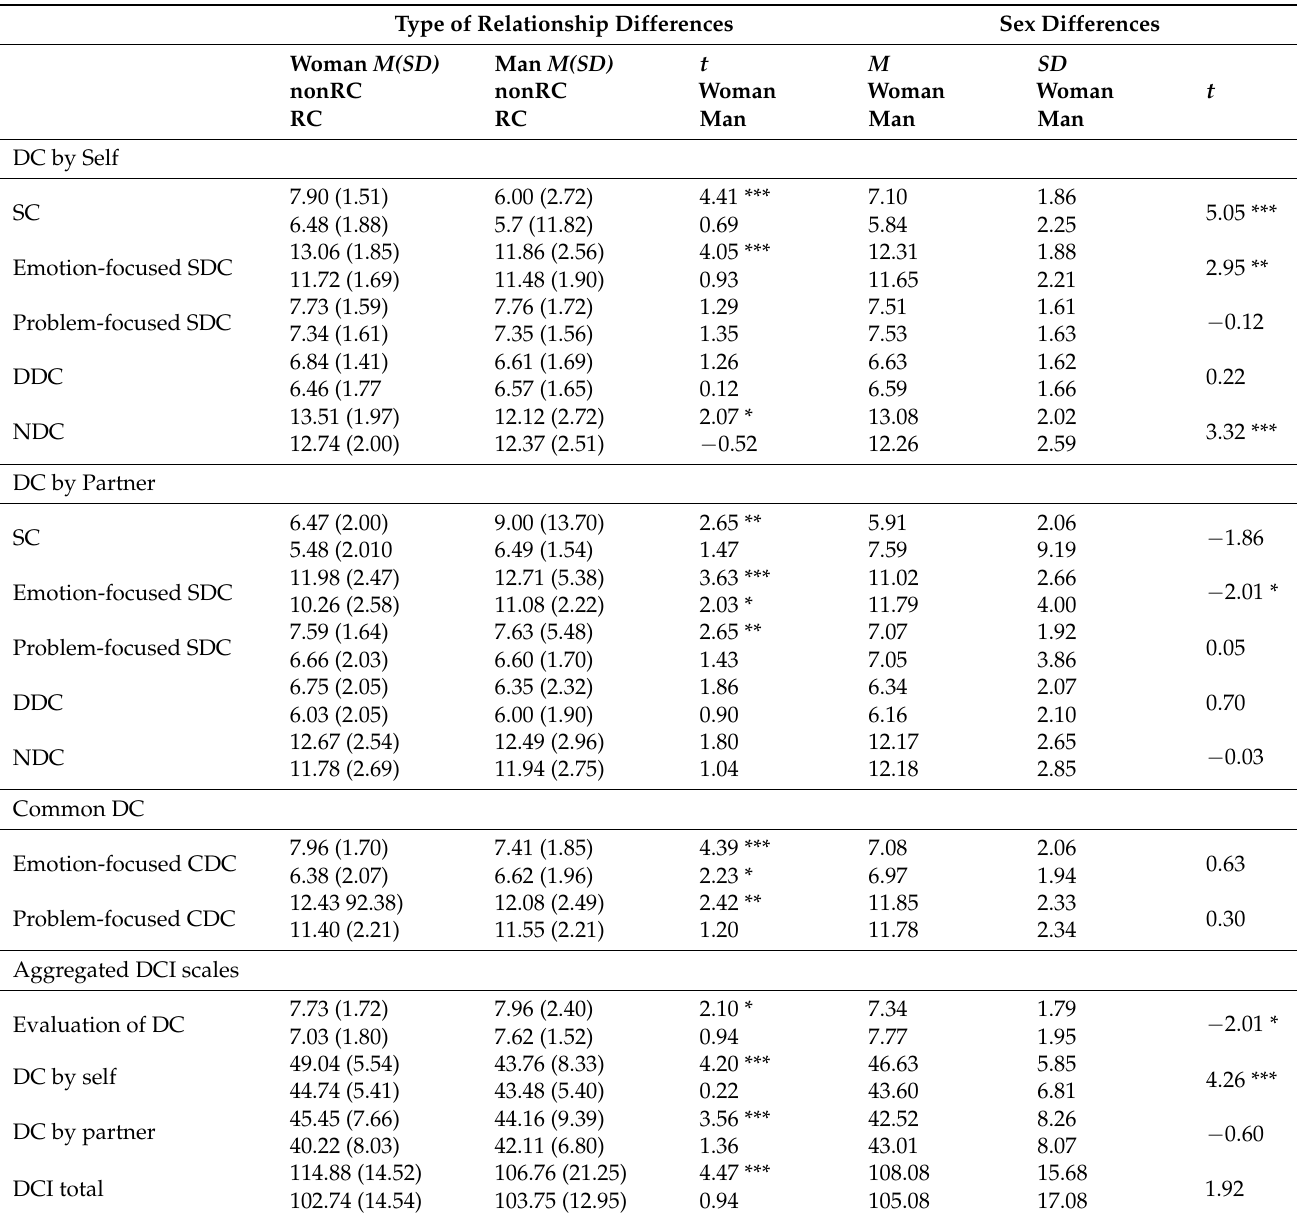
Table 2. Descriptive statistics, Cronbach’s α , and the sex and group differences